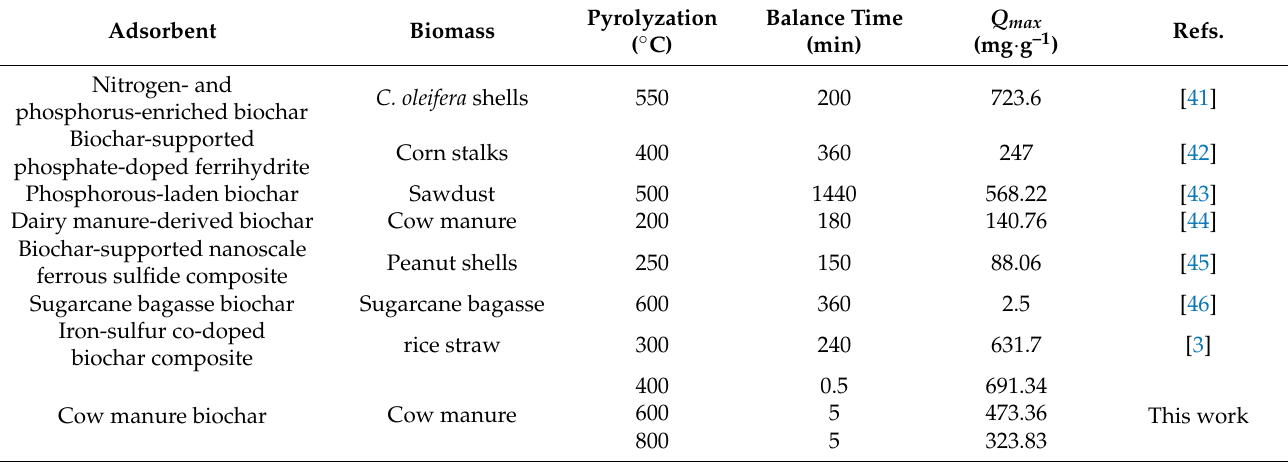
Figure 5. Isothermal adsorption model of Pb(II) by CMBC. ( a ) Langmuir model and ( b ) Freundlich Table 2. Adsorption capacities of different adsorbents for